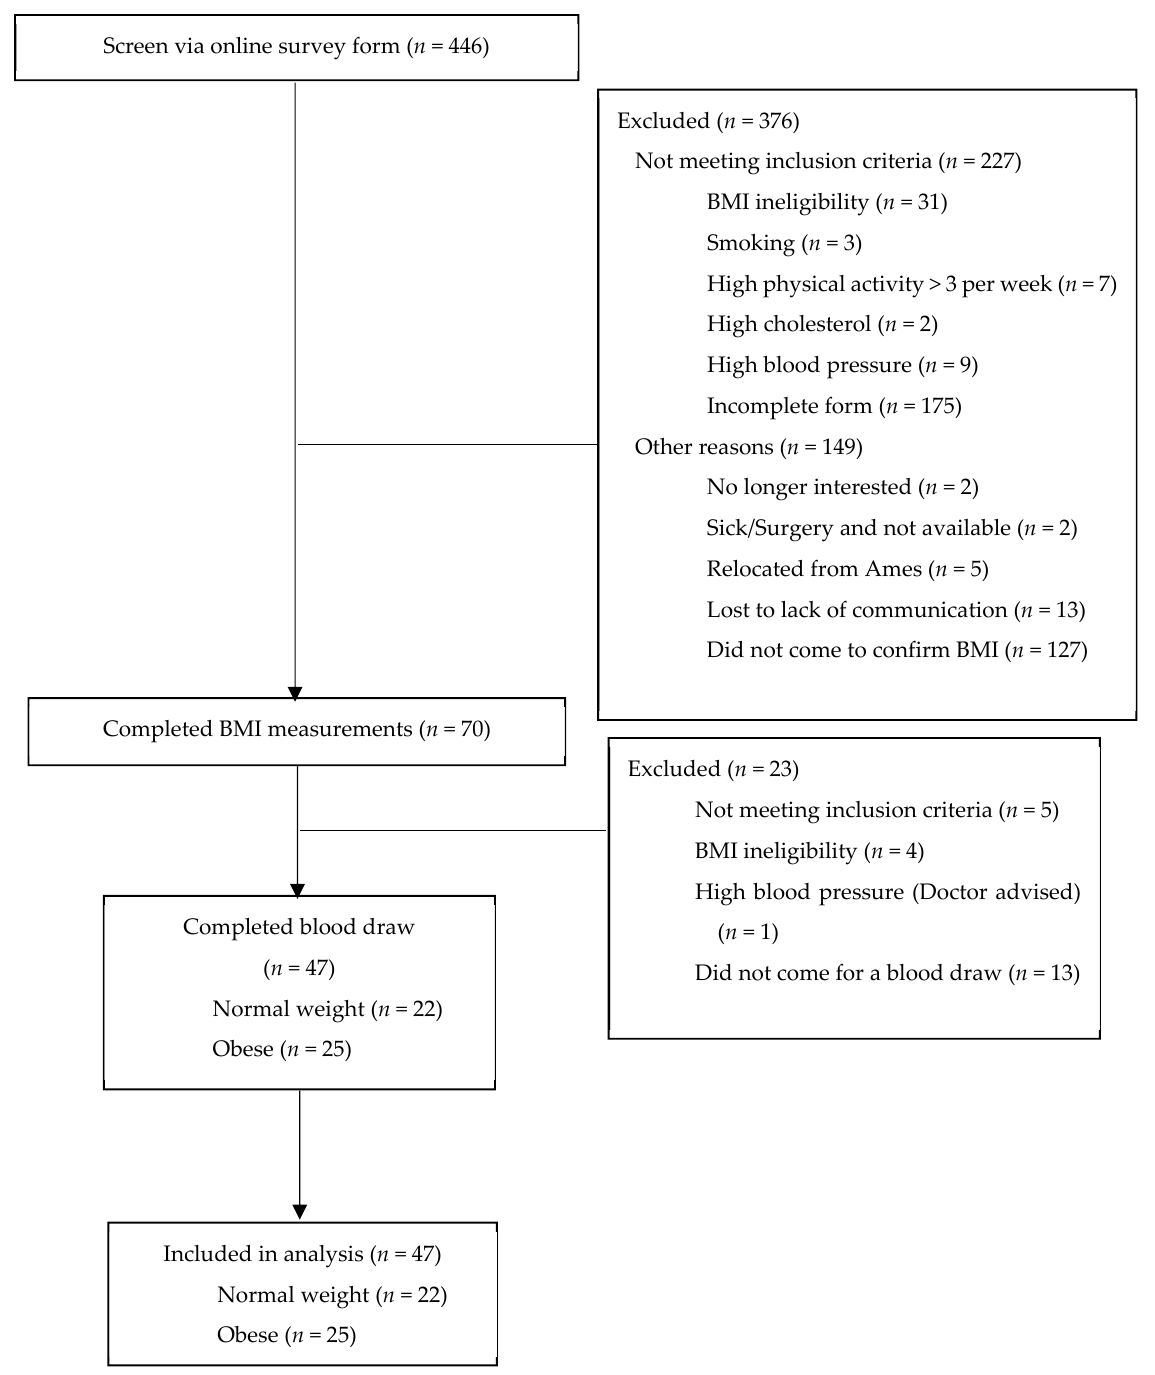
Figure 1. Study design and eligibility of participants.